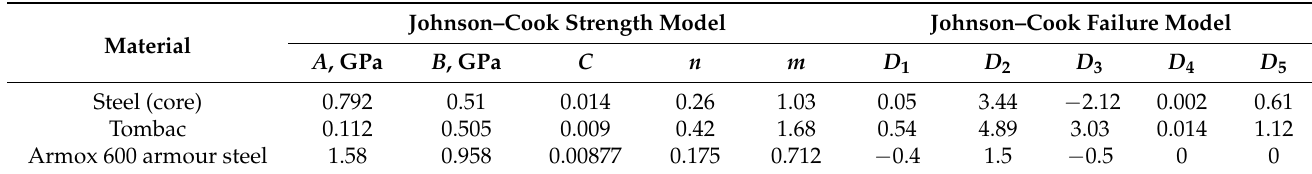
Table 2. Material parameters adopted for numerical investigation [18,25,26].